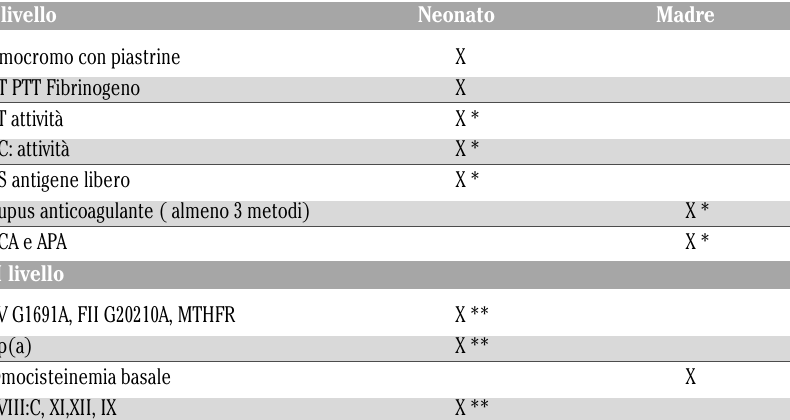
Tabella 2. Screening coagulativo e trombofilico in caso di trombosi